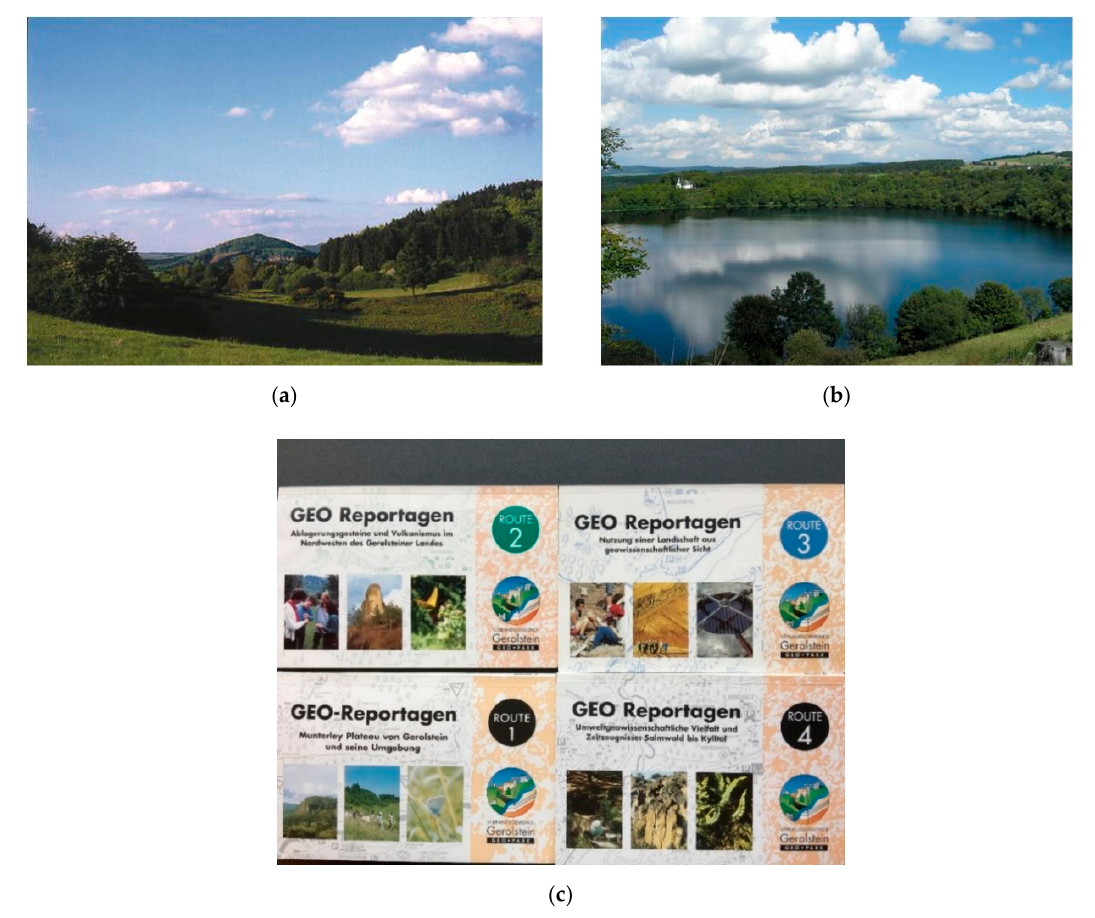
Figure 1. ( a ) Geopark Gerolstein/Vulkaneifel, Germany—Papenkaule view east to Rockeskyll Volcano head. ( b ) View of Weinfelder Maar close to Daun, Germany. ( c ) Geopark Gerolstein/Vulkan-eifel Germany [43].